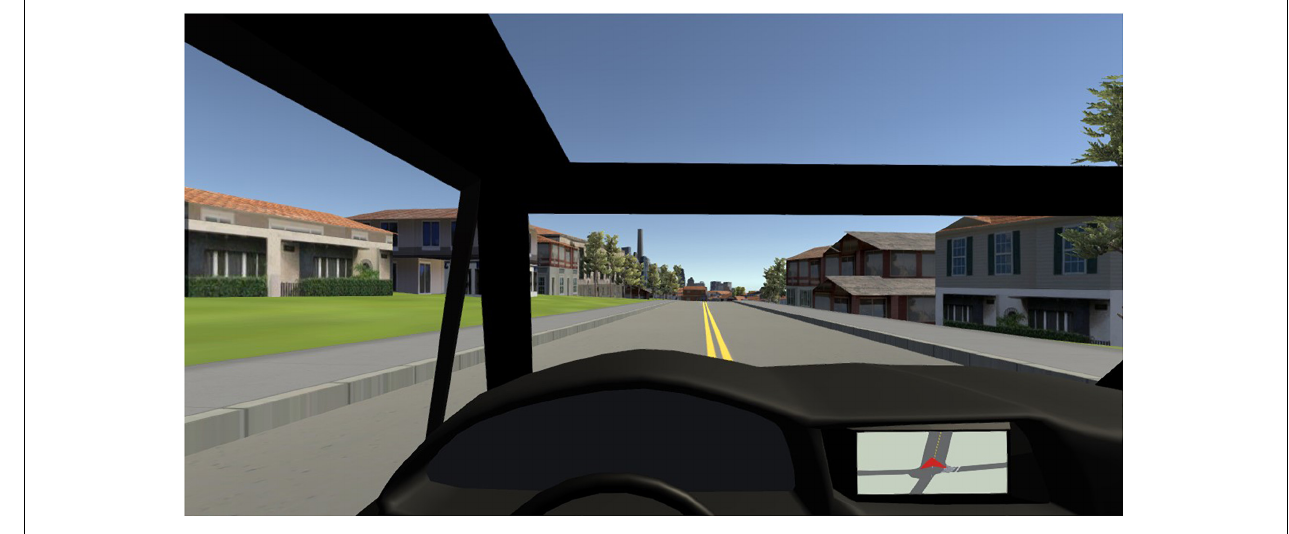
FIGURE 2 | Driver’s eye view of console and road ahead.